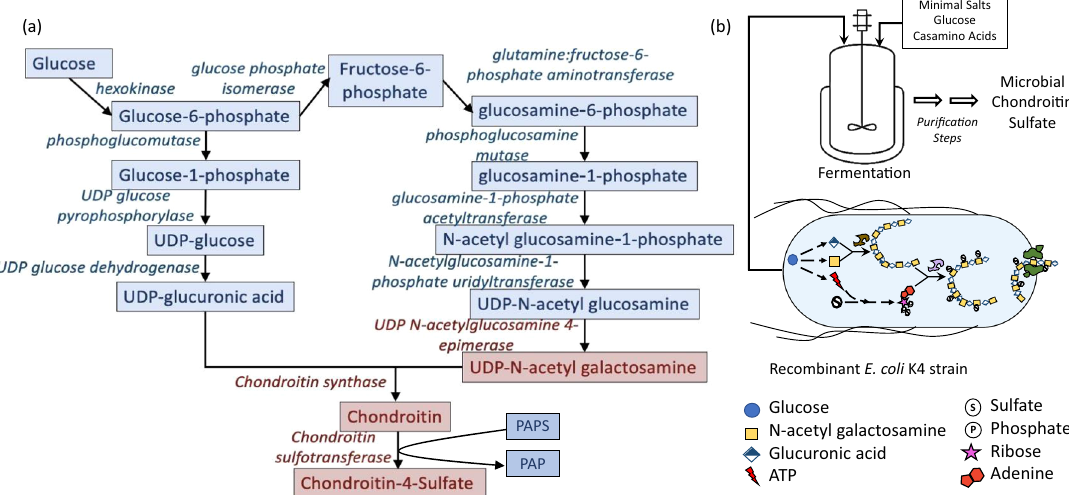
Fig. 1 In vivo production of different CS types. a Biosynthetic pathway for chondroitin production from glucose. The parts marked in red are absent in common lab strains of E. coli . b Schematic of microbial CS production from minimal nutrient media using recombinant E. coli